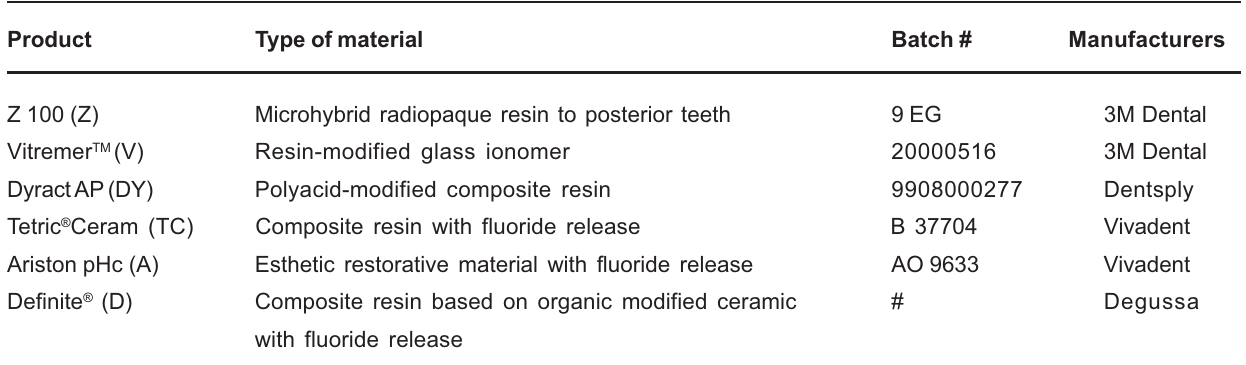
# Material provided by the manufacturer in capsules without the